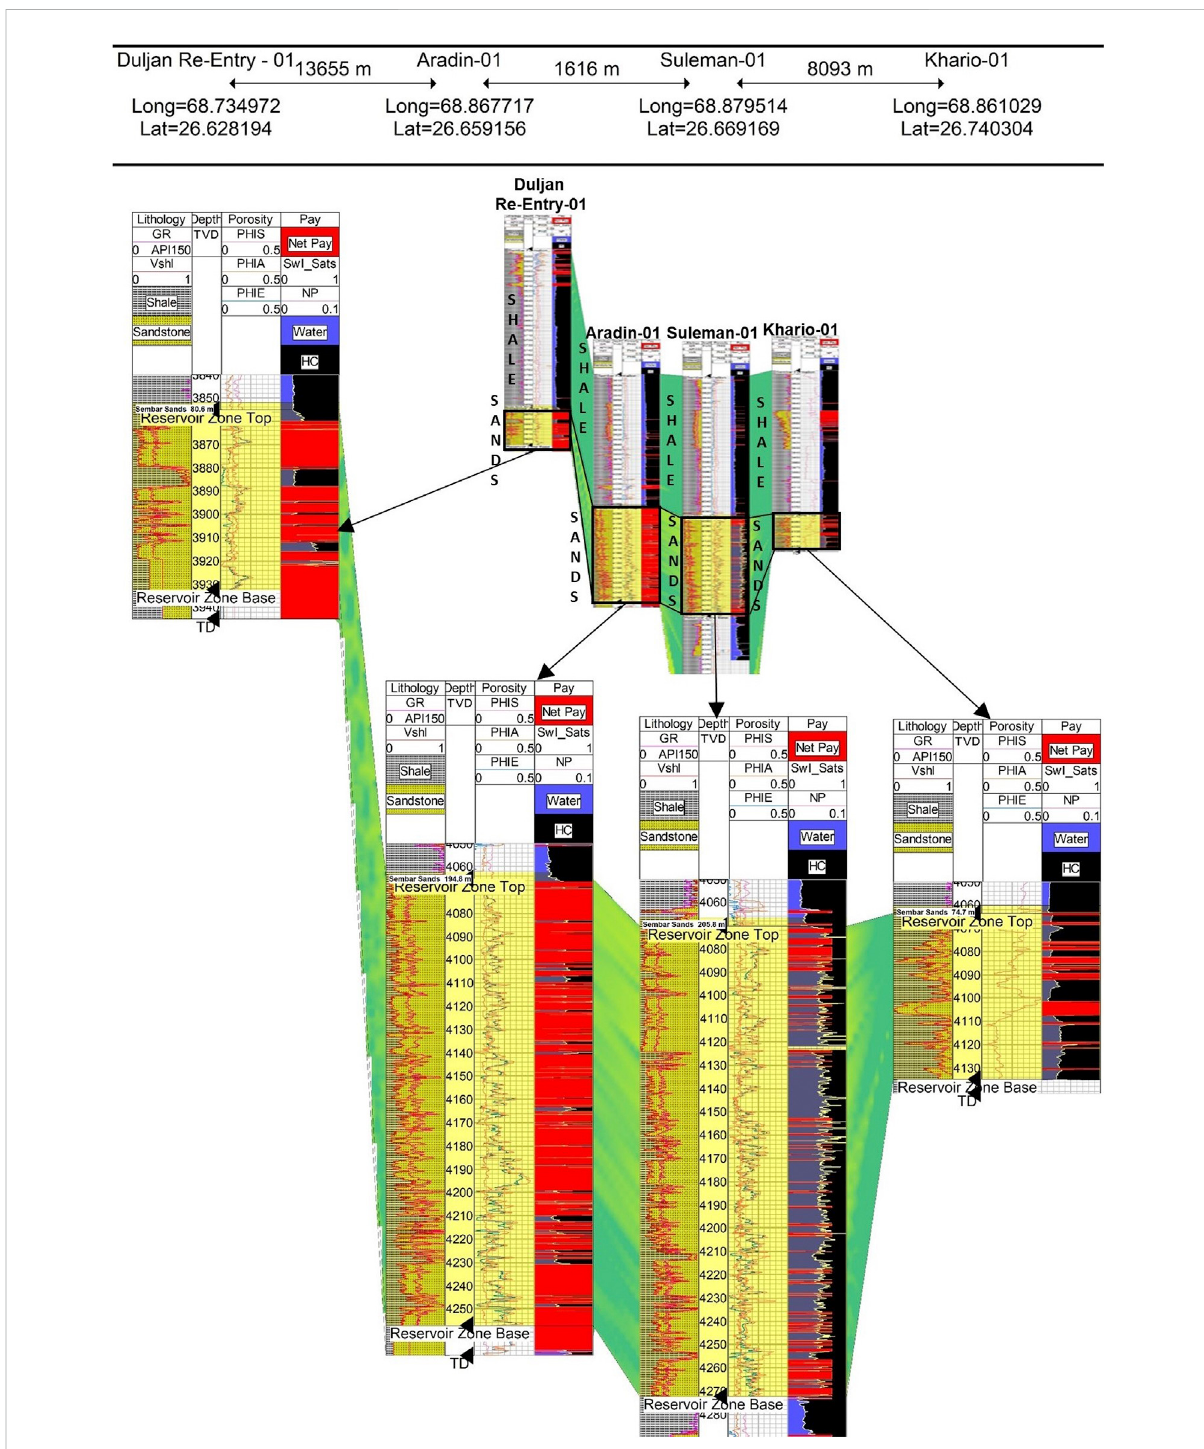
FIGURE 11 Structural correlation of wells; Duljan Re-Entry-01, Aradin-01, Suleman-01, and Khario-01 (structurally shallower from the west to